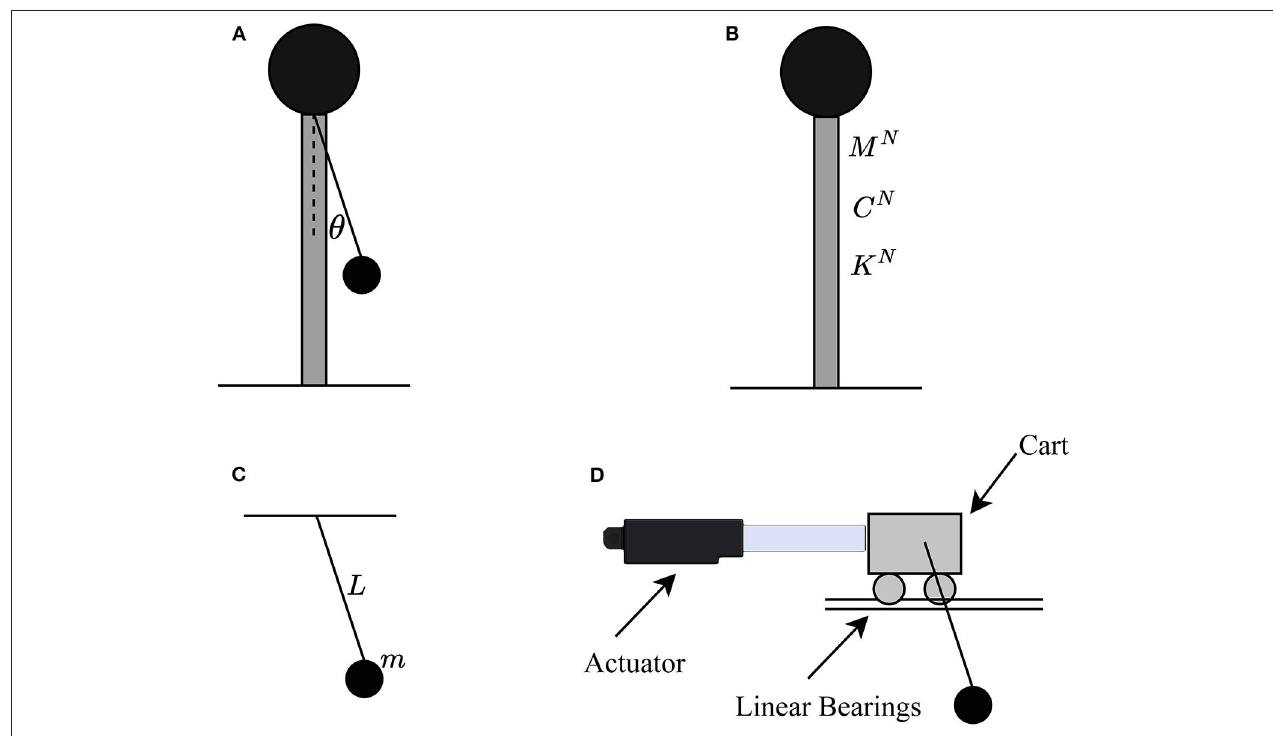
FIGURE 3 | Hybrid model of CS1: (A) Reference structure, (B) Numerical substructure, (C) Virtual physical substructure, (D) Control plant.